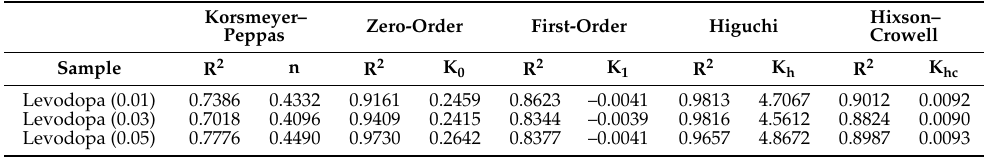
Table 5. Results of mathematical drug release models for all scaffolds. Levodopa (0.01): Scaffolds have levodopa at a concentration of 0.01 mg/mL. Levodopa (0.03): Scaffolds have levodopa at a concentration of 0.03 mg/mL. Levodopa (0.05): Scaffolds have levodopa at a concentration of 0.05